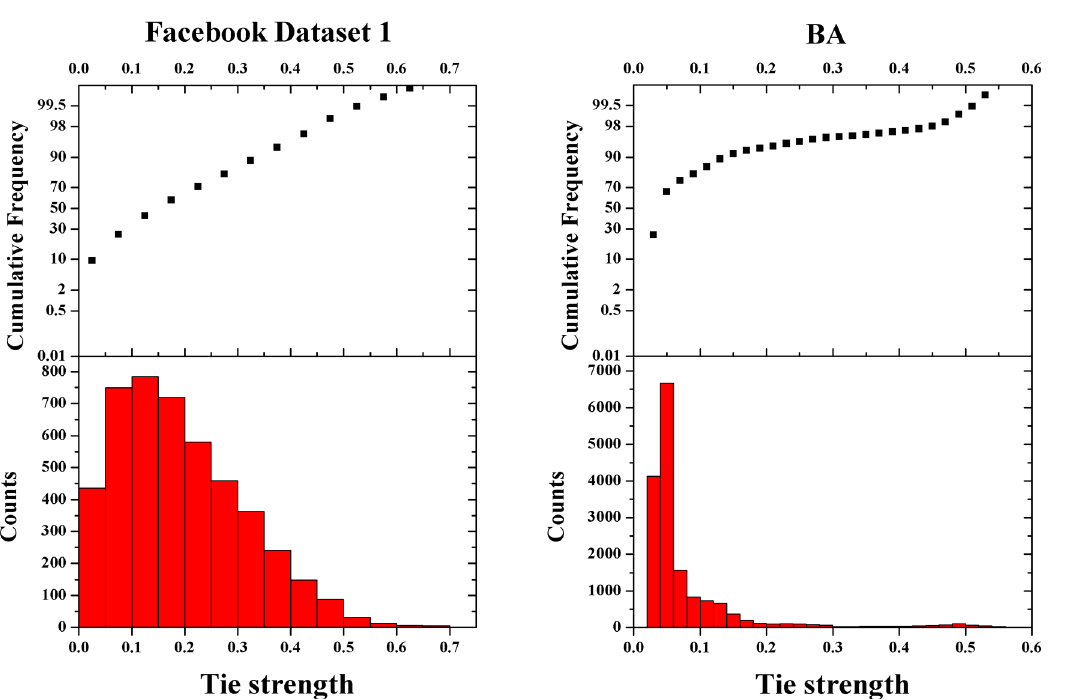
Figure 1. A comparison of the tie strength distributions between a BA network and the network we collected from Facebook.com. The two networks have exactly the same number of nodes and edges. The strength of each tie is calculated by using equation 1. It is obvious that most of the ties in the BA network have approximately zero tie strength, while the Facebook network exhibits a diverse tie strength